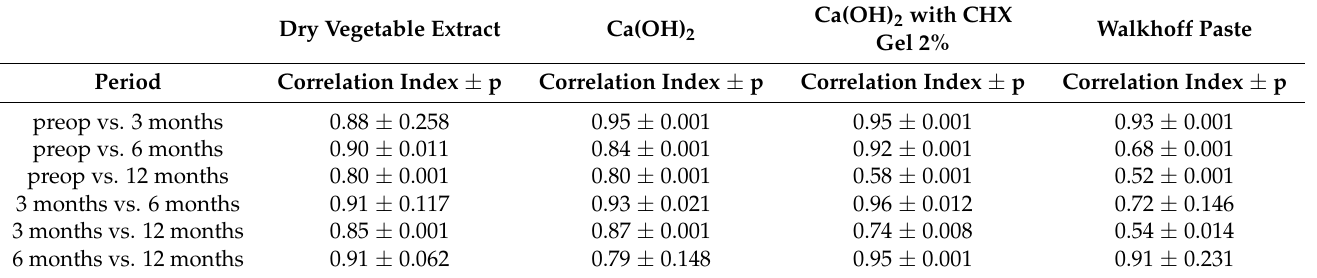
Table 3. Correlations between PAI values recorded at different time